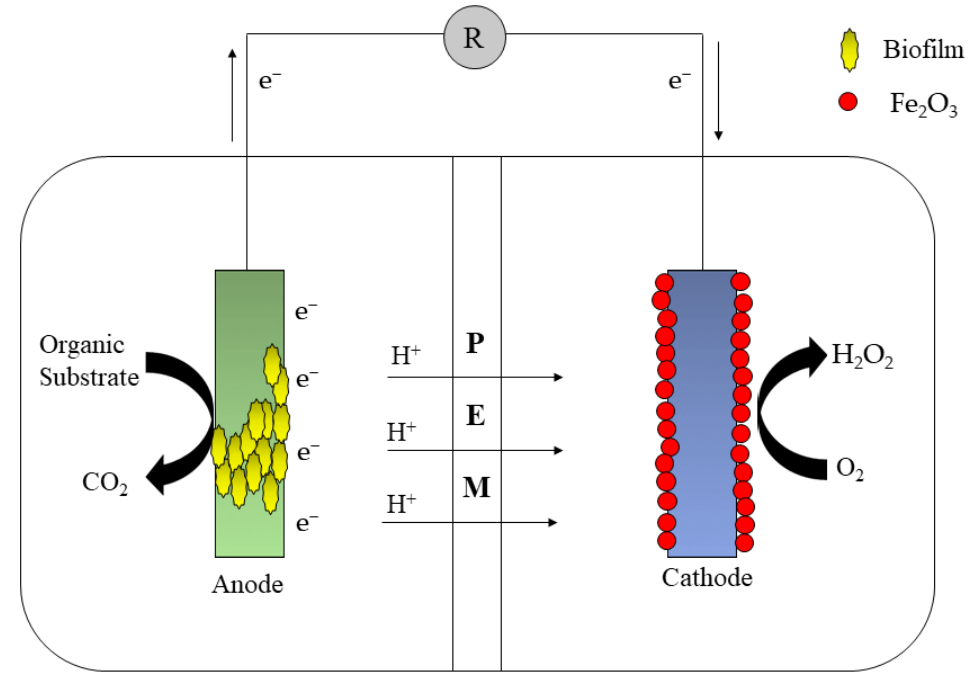
Figure 9. MFC integrated with bio-electro-Fenton.